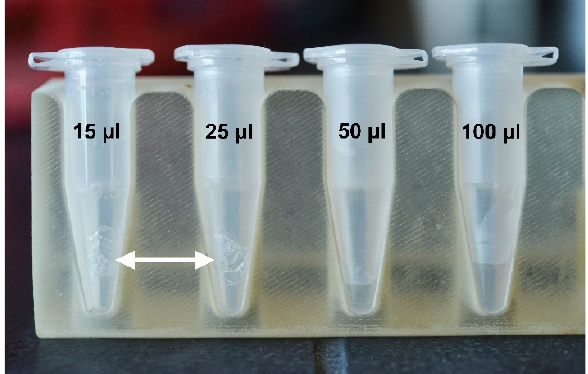
Figure 6. Representative images of microneedle inside tubes of TE buffer. A MN is placed into an Eppendorf tube with 15, 25, 50, and 100 μ L of TE. (n = 3). White arrows indicate an undissolved MN in the tube after 10 min of incubation at 115 °C.